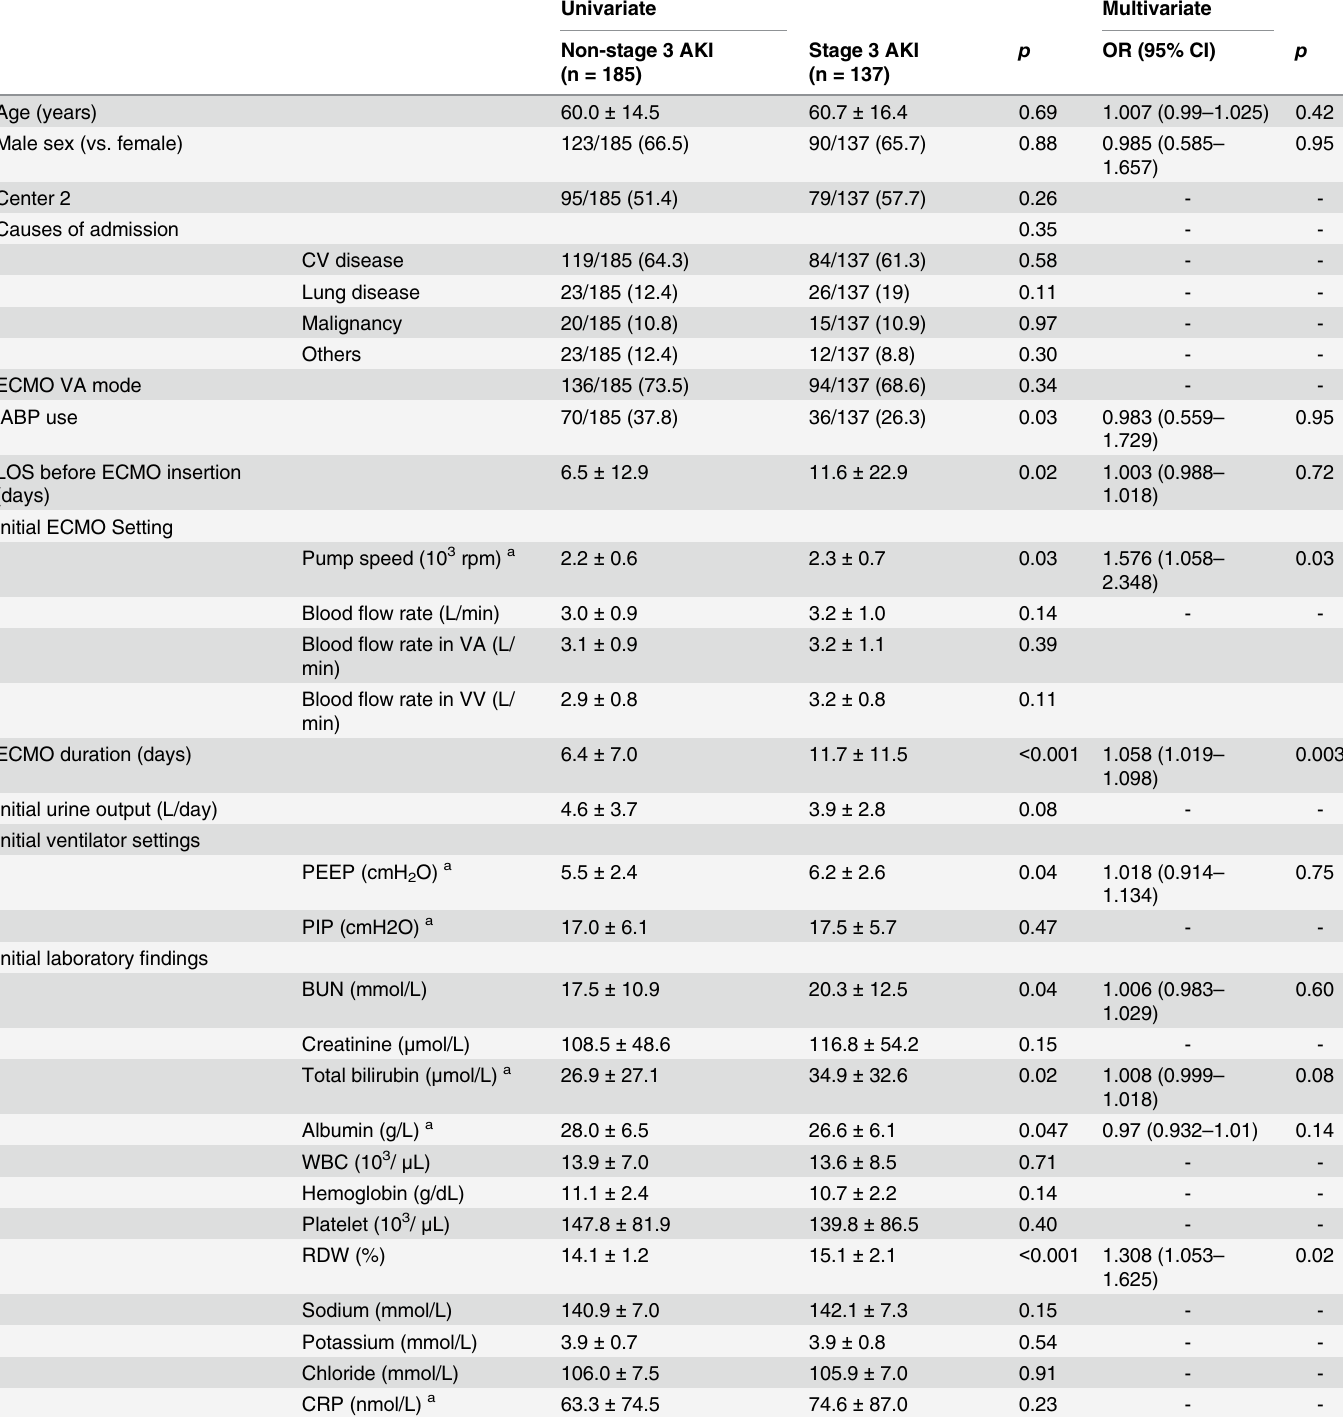
Table 6. Odds ratios for stage 3